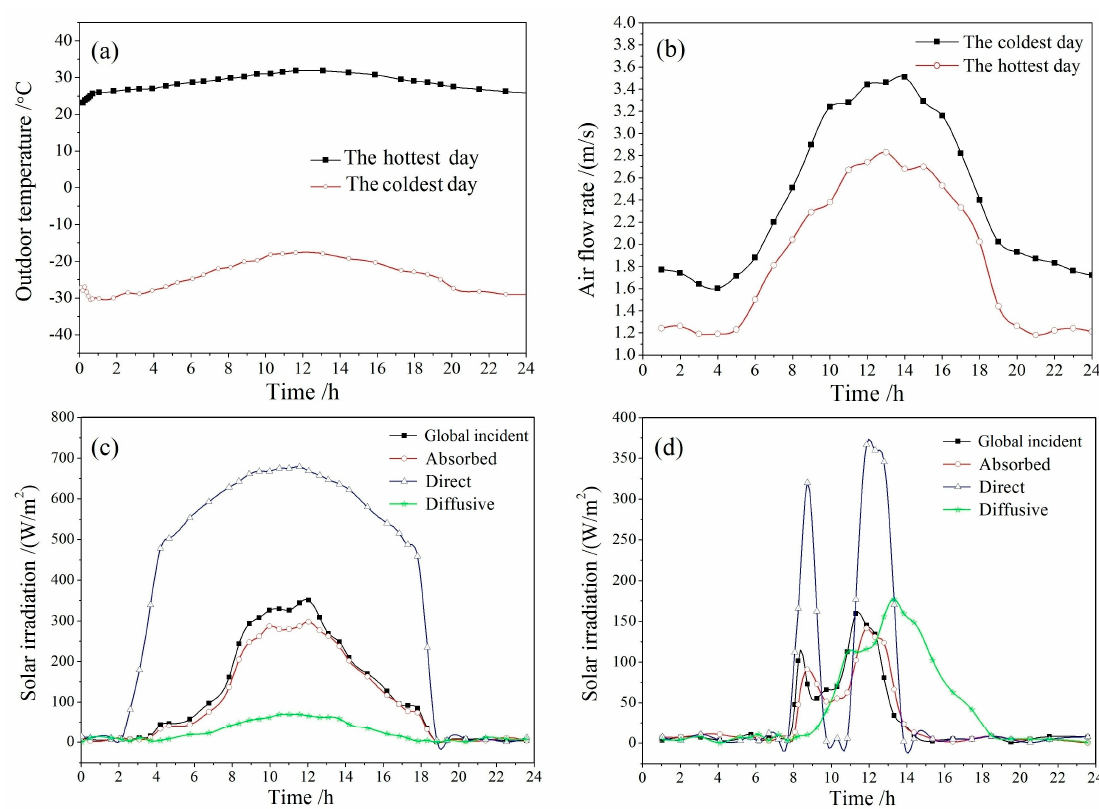
Figure 10. ( a ) Outdoor temperature and ( b ) air flow rate as a function of time; solar irradiation intensity Figure 10. (a) Outdoor temperature and (b) air flow rate as a function of time; solar irradiation vs. time on the ( c ) hottest day and ( d ) coldest intensity vs. time on the (c) hottest day and (d) coldest day.